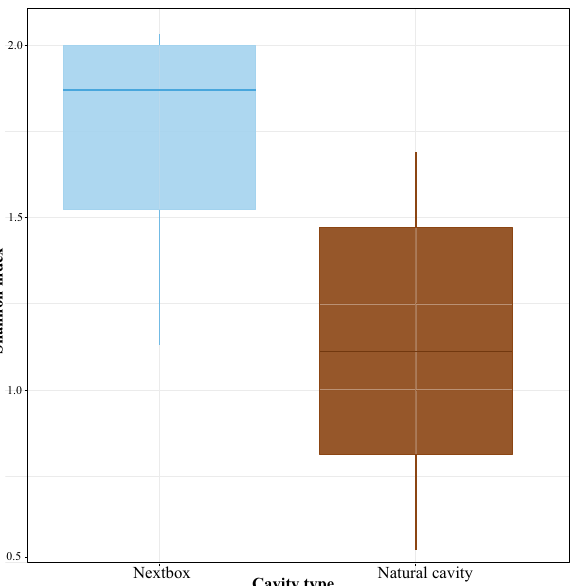
Figure 2. Microbiota alpha-diversity based on Shannon’s diversity collected from nestlings reared in nestboxes and natural cavities. The figure was generated in R version 4.0.0 68